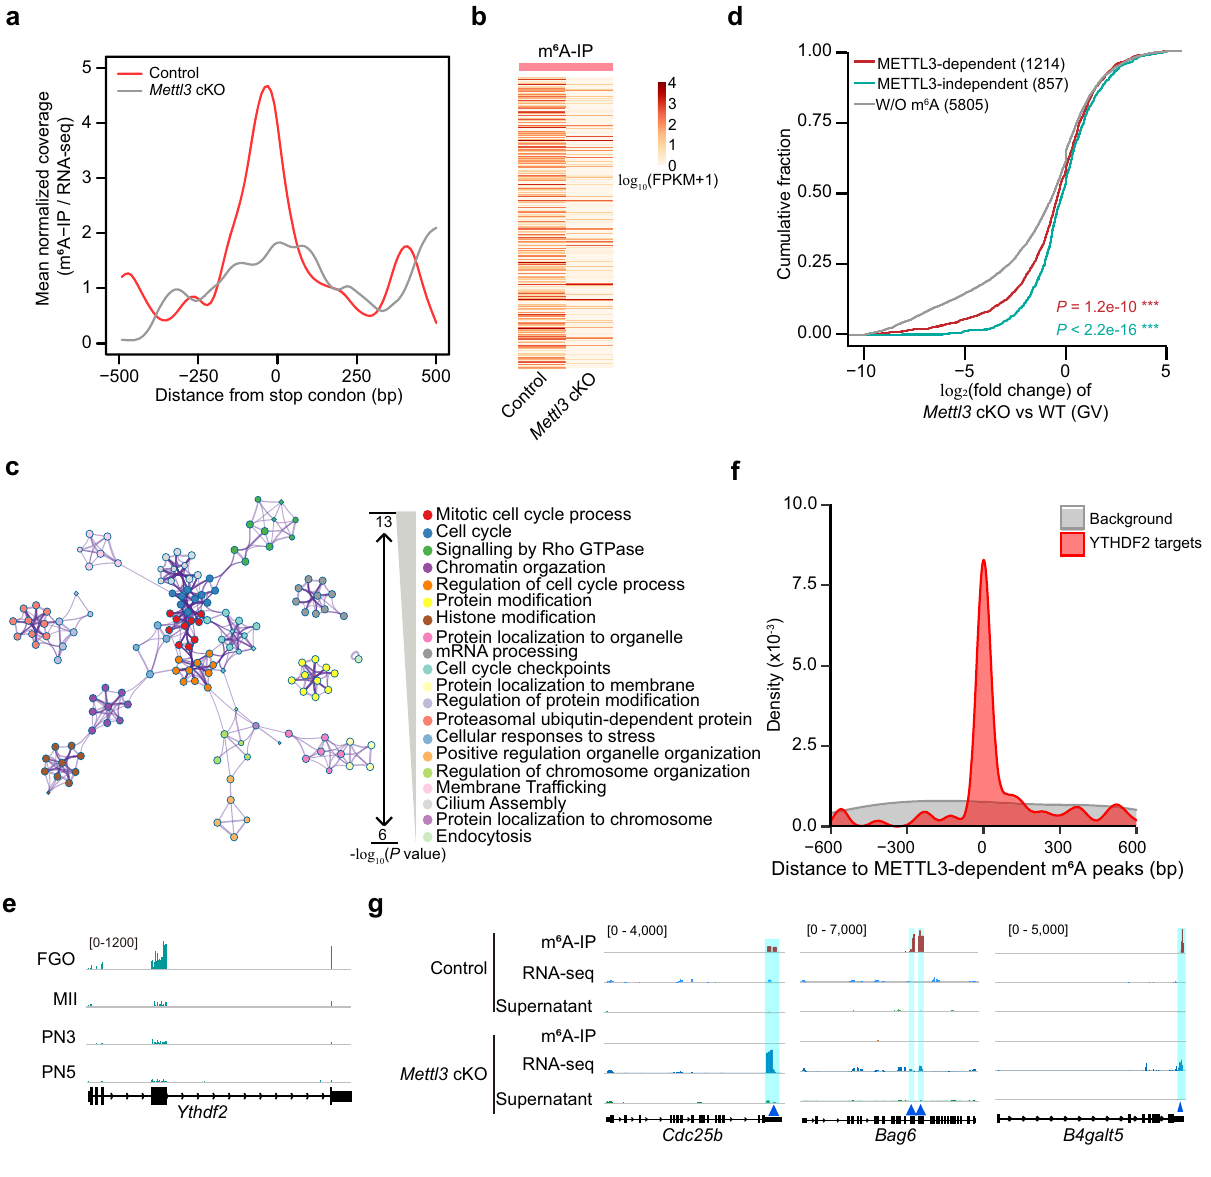
Fig. 2 | METTL3-catalyzed m 6 A deposition mediates the degradation of m 6 A modi fi ed RNAs in GV oocytes. a Metagene pro fi les depicting m 6 A signals sur- rounding the stop codon in control and Mettl3 conditional knockout (cKO) GV oocytes. b Heatmap showing the METTL3-dependent m 6 A modi fi ed transcripts in GV oocytes. c Functional annotation analysis of METTL3-dependent m 6 A modi fi ed transcripts using Metascape. The enrichment and P value was calculated with default parameters using hypergeometric test of functional annotation in DAVID database. d Cumulative frequency of expression change (log 2 (fold change)) of METTL3-dependent, METTL3-independent m 6 A modi fi ed and unmodi fi ed RNAs upon Mettl3 silencing. P values were determined by one-sided Wilcoxon